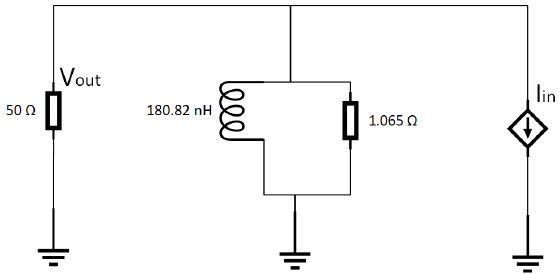
Figure 6. Equivalent circuit of the F-65 current monitor probe calibration procedure.